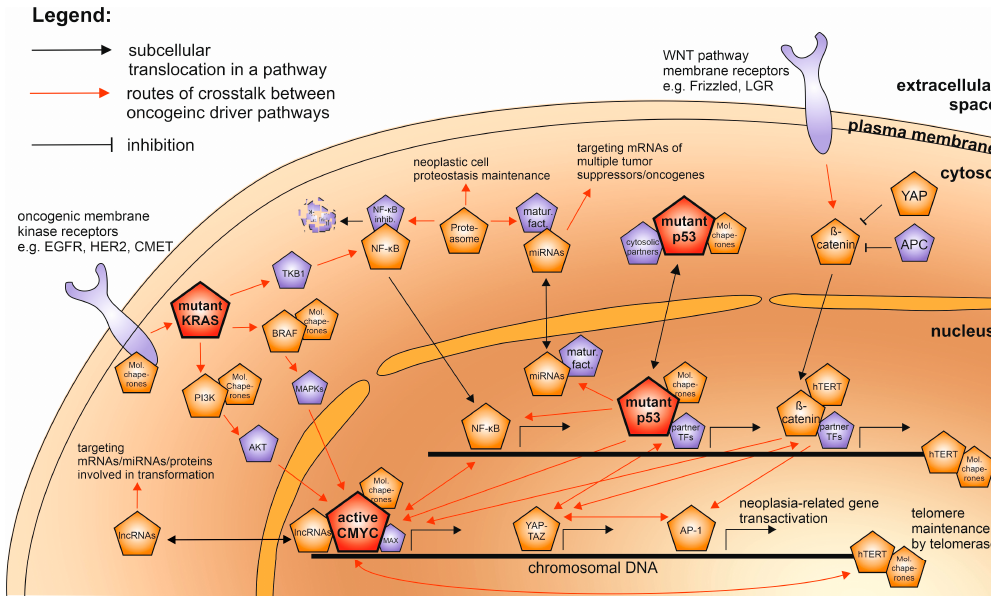
Figure 4. The subcellular localization of the interplay network of the human oncogenic drivers as described in the text. The most decisive and universal drivers—mutant p53, KRAS, and hyperactive CMYC—are highlighted in red; the rest of the universal drivers are in orange and additional oncogenic partner factors described in the text are shown in purple. The links between oncoproteins of different pathways are shown either by red arrows or, when a direct protein complex is formed, by overlapping symbols.